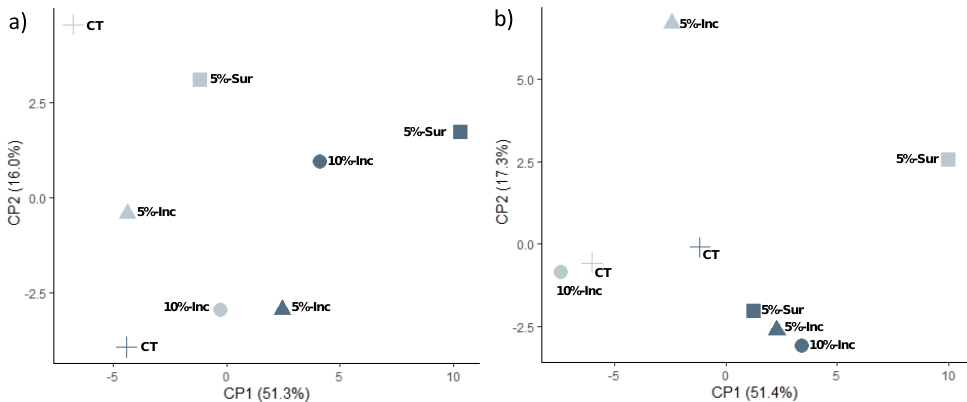
Figure 1. Principle component analysis (PCA) ordination plots using FAME groups indicating changes to the microbial community structure with and without biochar addition for ( a ) 0–15 cm and ( b ) 15–30 cm of depth. (+)-control; ( ▲ )-5%-Inc; ( ■ )-5%-Sur, and (●)-10%-Inc soils. Numbers in parentheses along each axis represents the percent variance explained. Light symbols represent samples from 2018, and dark symbols represent samples from 2019.